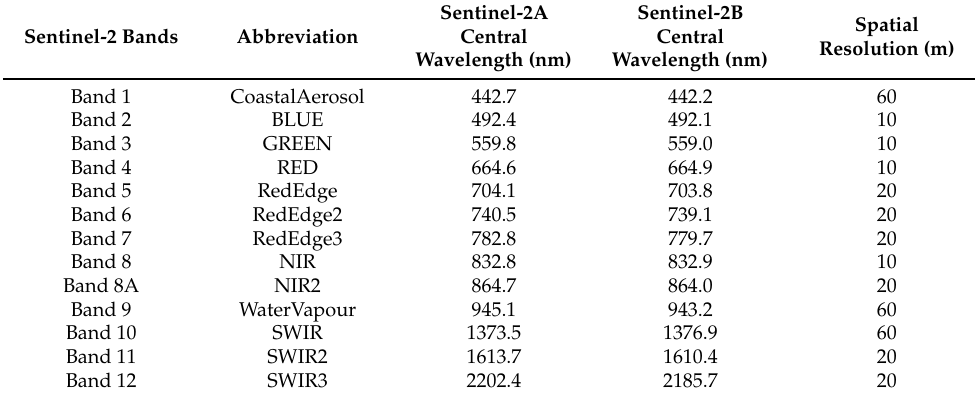
Table 1. Spectral bands for the Sentinel-2.